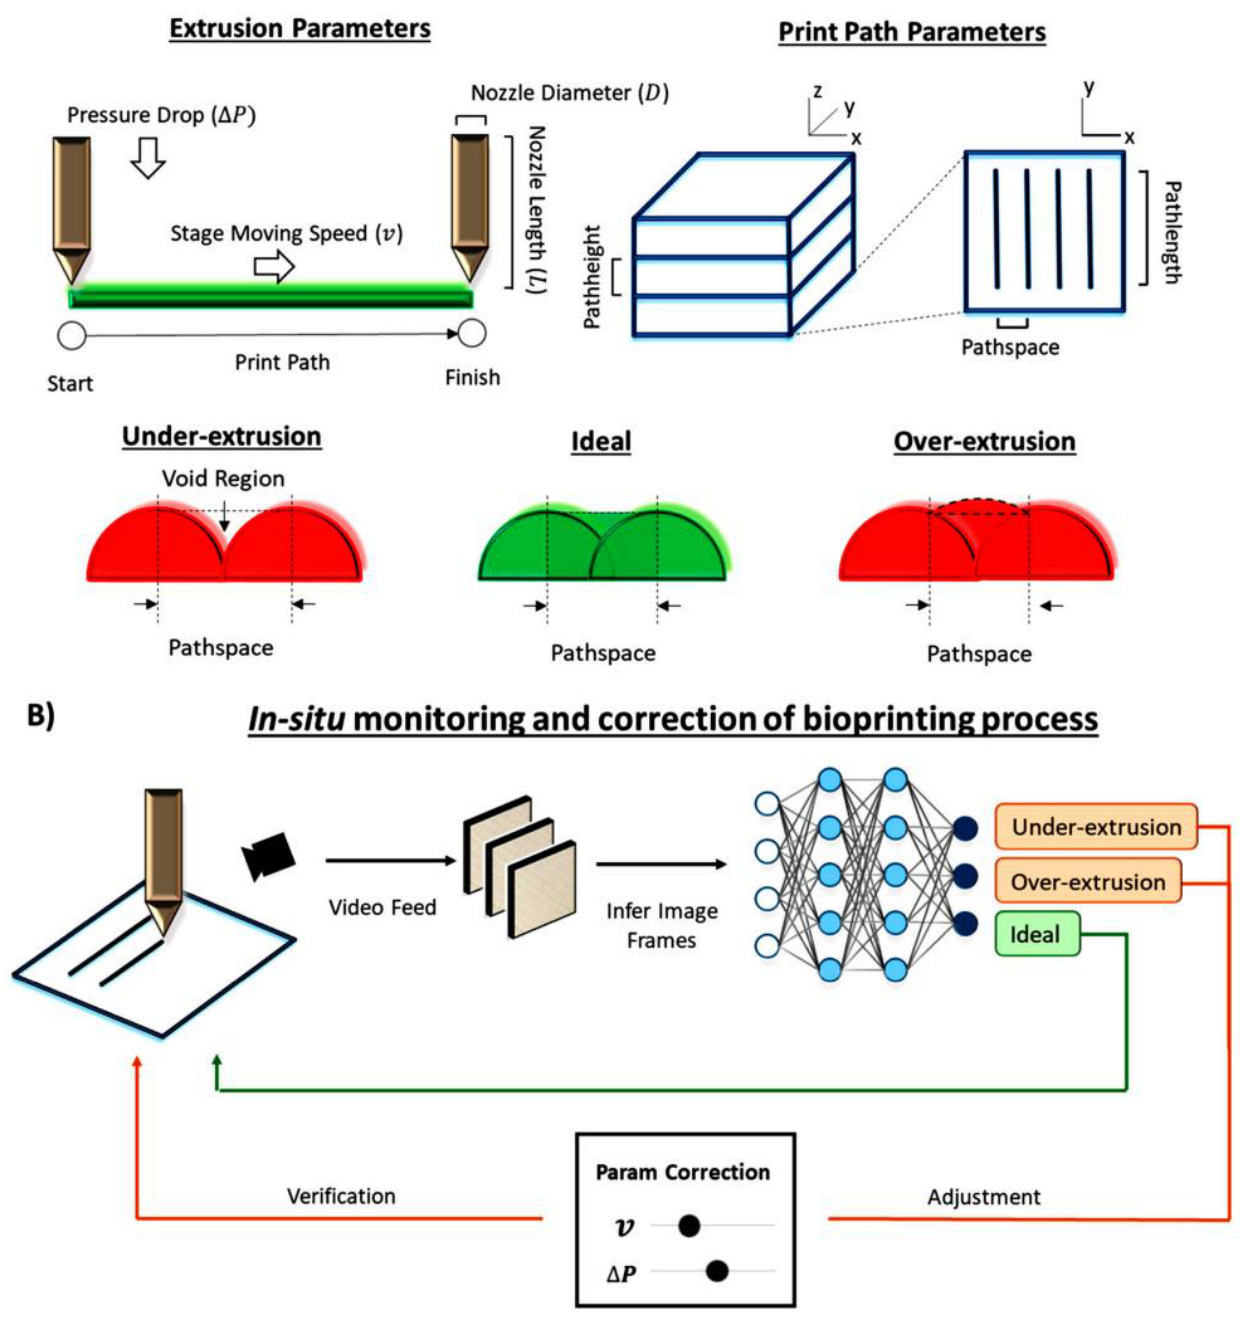
Figure 9. ( A ) Three-dimensional bioprinting optimisation processes. ( B ) Computer vision method used for the optimisation and correction of 3D bioprinting using ML approaches. Reprinted with permission from Ref. [12]. 2020, Taylor & Francis Ltd., www.tandfonline.com (accessed on 12 September